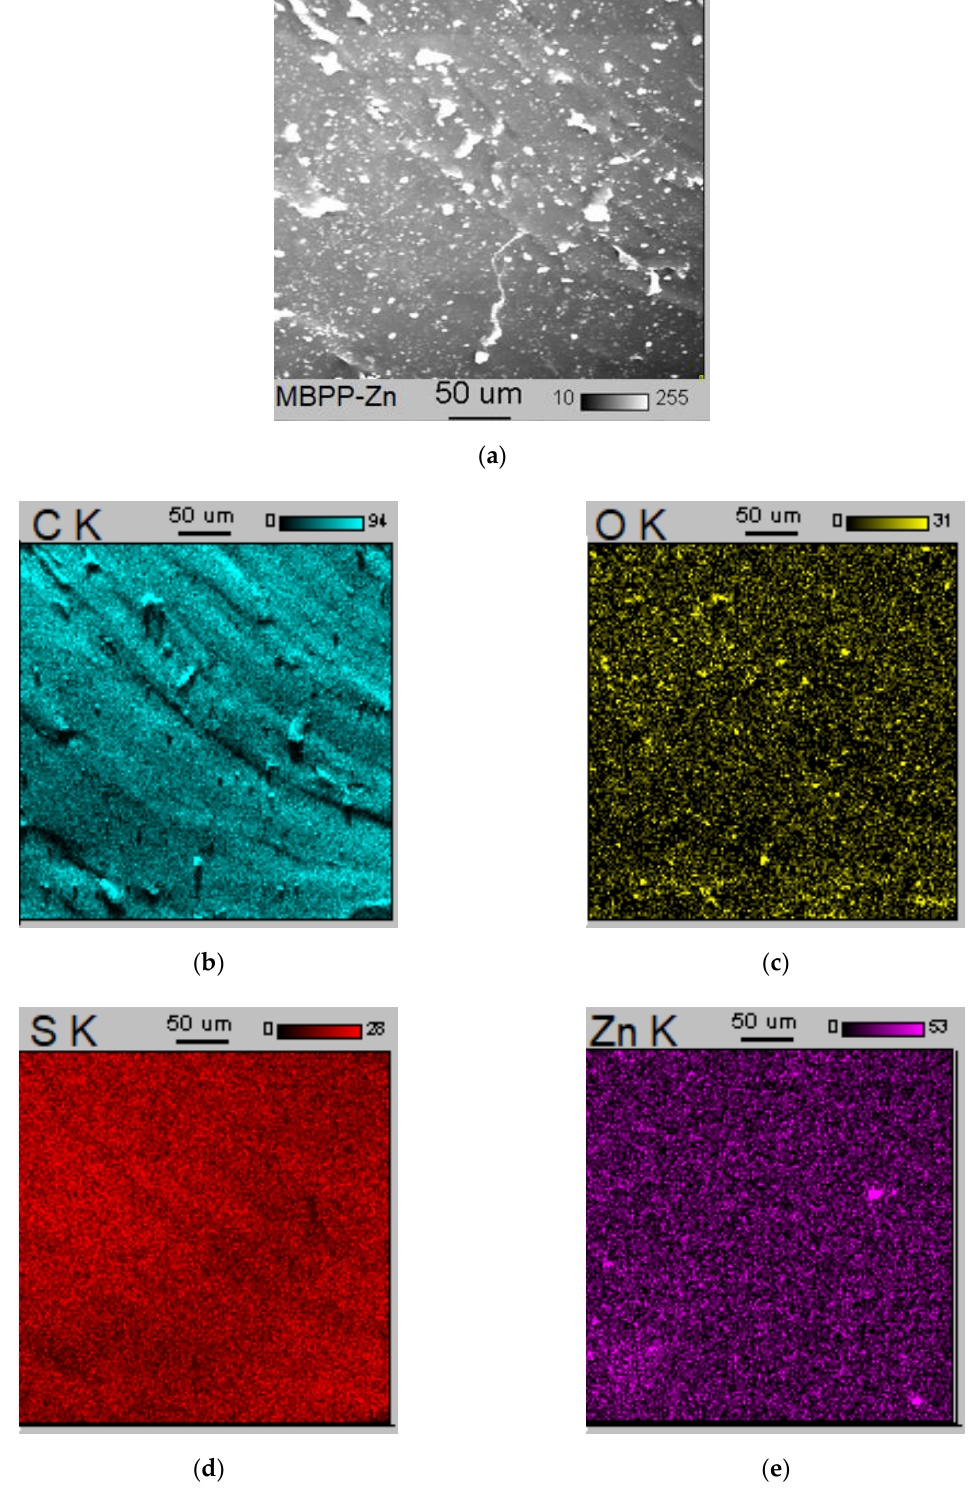
Figure 10. SEM image and EDS maps for SBR vulcanizate containing MBPP-Zn: ( a ) SEM image; ( b ) EDS map for C; ( c ) EDS map for S; ( d ) EDS map for Zn.